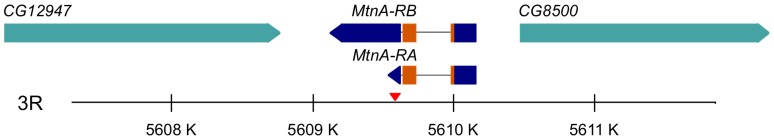
Structure of the MtnA locus.Two transcripts that differ only in their 3’ UTRs have been annotated for MtnA (MtnA-RA and MtnA-RB). Dark blue boxes represent the UTRs with the arrowheads indicating the direction of transcription. Orange boxes represent the coding exons. The thin lines joining the coding exons represent introns. The location of the polymorphic indel, which is shared by both transcripts, is indicated by the red triangle. For the coding genes flanking MtnA (CG12947 and CG8500), only the whole gene model is shown.